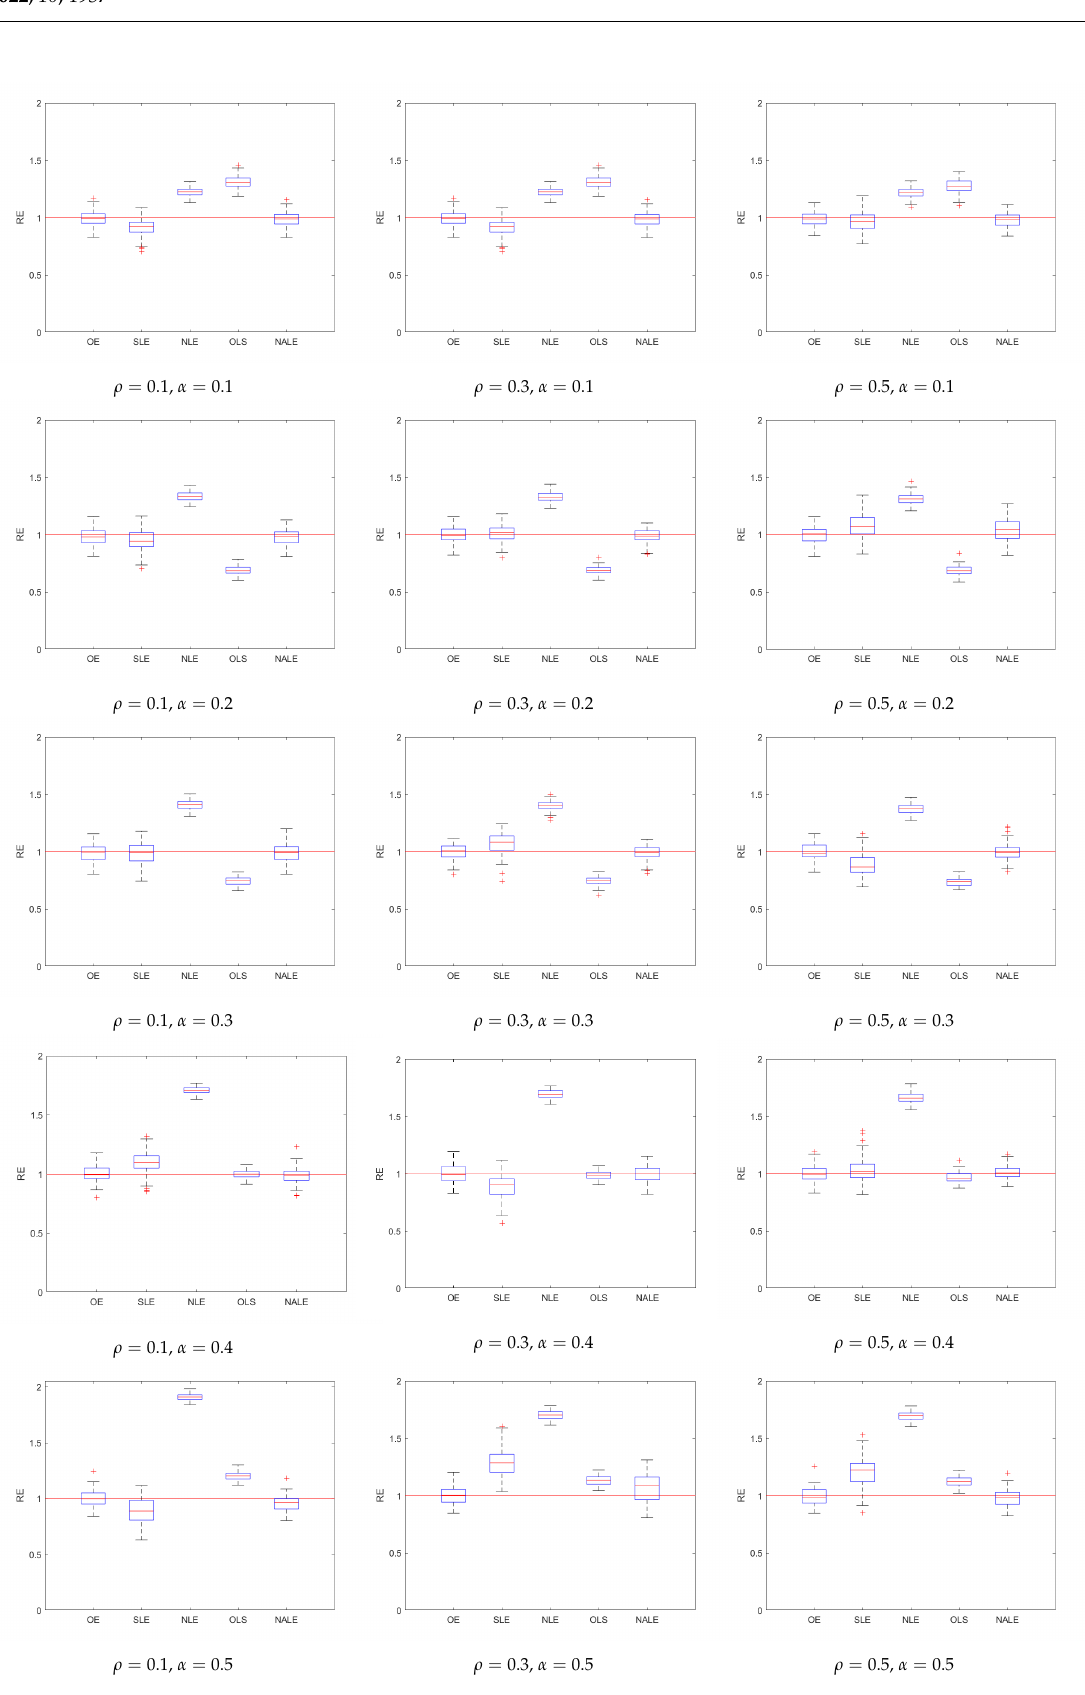
Figure 1. Boxplots of 100 RE values for five estimators, true σ 2 =